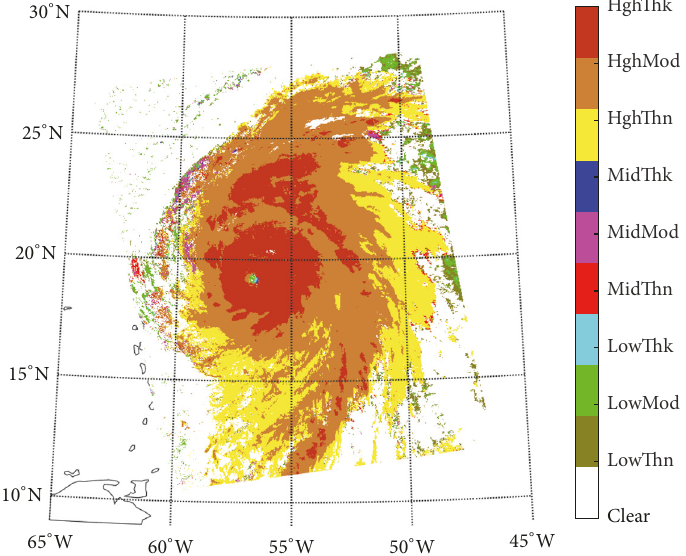
Figure 11: ISCCP cloud-type classification of TC Bill as observed by Aqua MODIS on August 19,